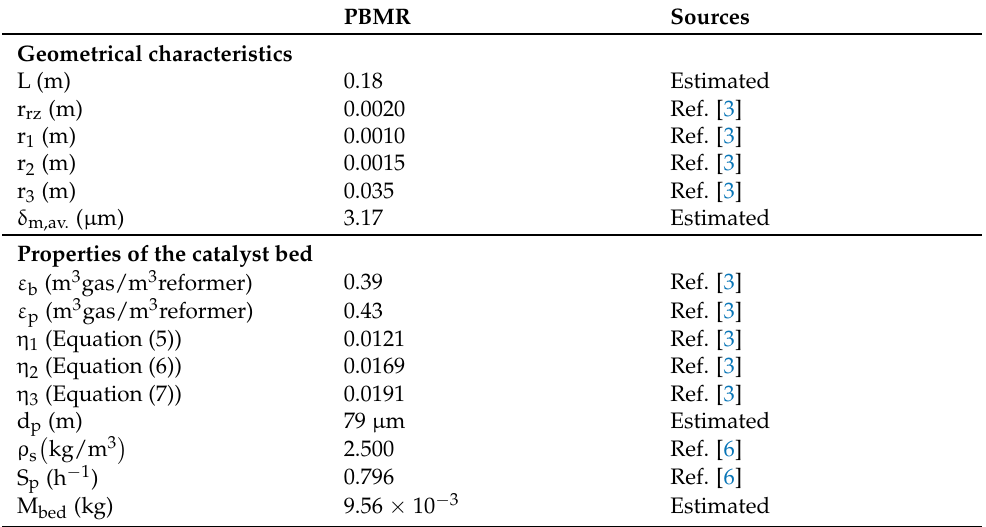
Table 1. PBMR’s Geometrical characteristics and the catalytic bed’s properties.